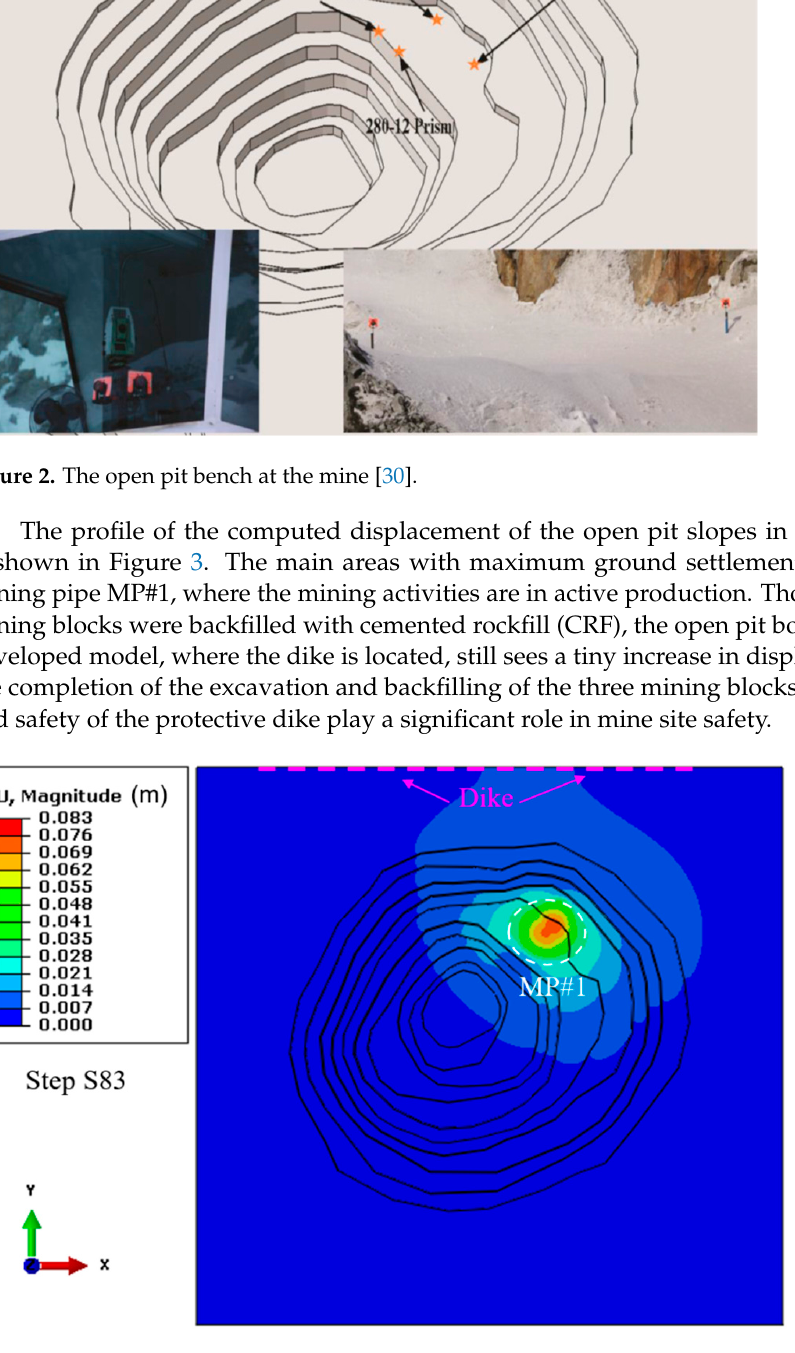
Figure 3. Computed displacement in the FE model before sill pillar recovery. The comparison of the accumulated ground displacement between the in situ recorded data and the computed FE model results is shown in Table 2. The relative errors in different zones are 2.57% and 8.01% in zone 1 and 2, respectively. The average relative error is 5.29%, which is acceptable in mining engineering simulation analysis